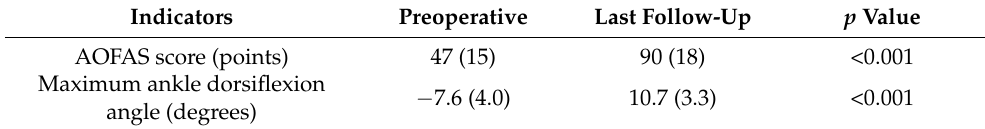
Table 3. The outcomes of AOFAS scores and maximum ankle dorsiflexion angles in the open group.